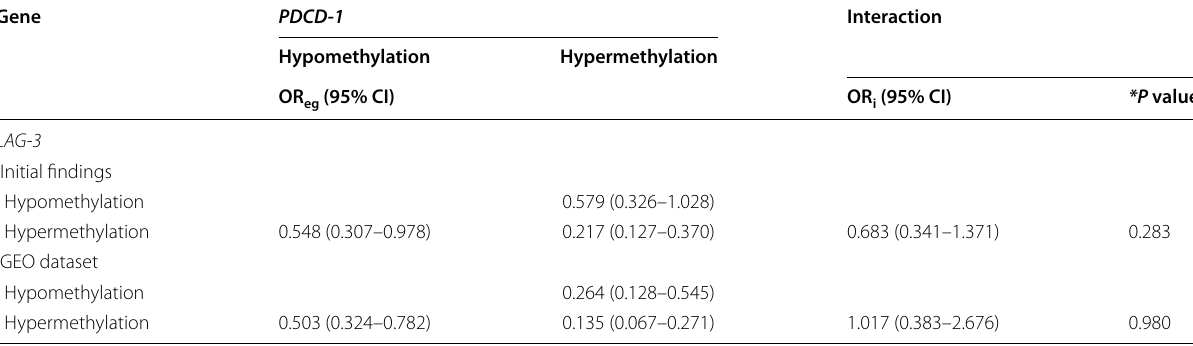
CI, confidence interval; OR, odds ratio * P values < 0.05 were considered statistically